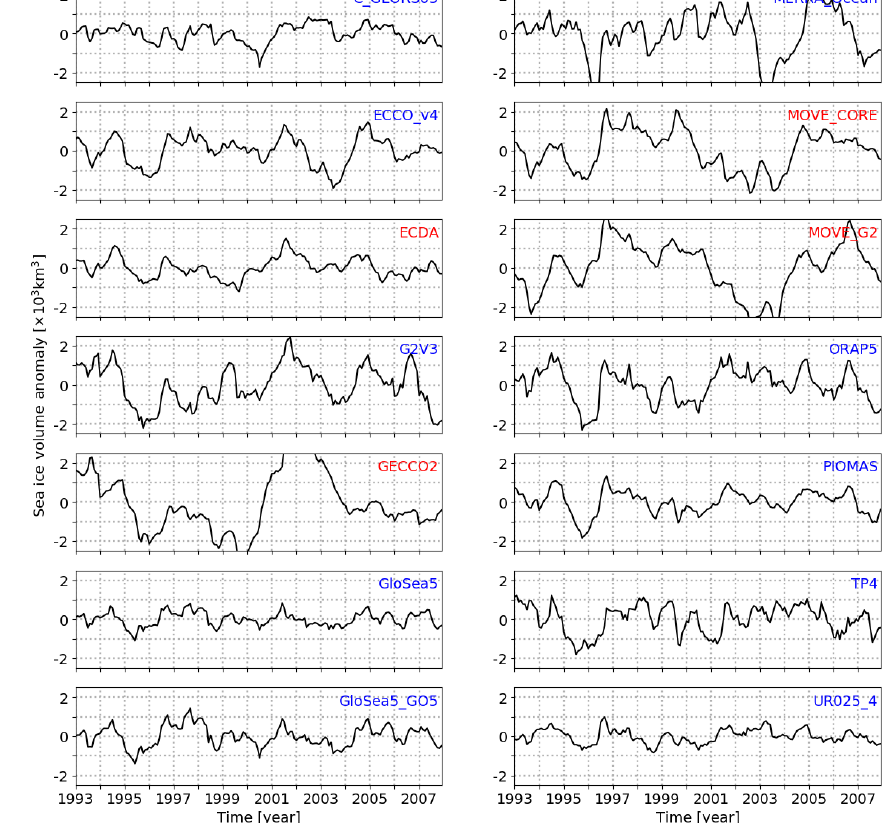
Figure 1. Sea ice volume anomalies estimated from all reanalyses. Anomalies are calculated by excluding the trend and the seasonal cycle. Tick labels are placed at the first day of the respective year. Reanalyses labeled in blue and red highlight whether the datasets were built with or without sea ice data assimilation,